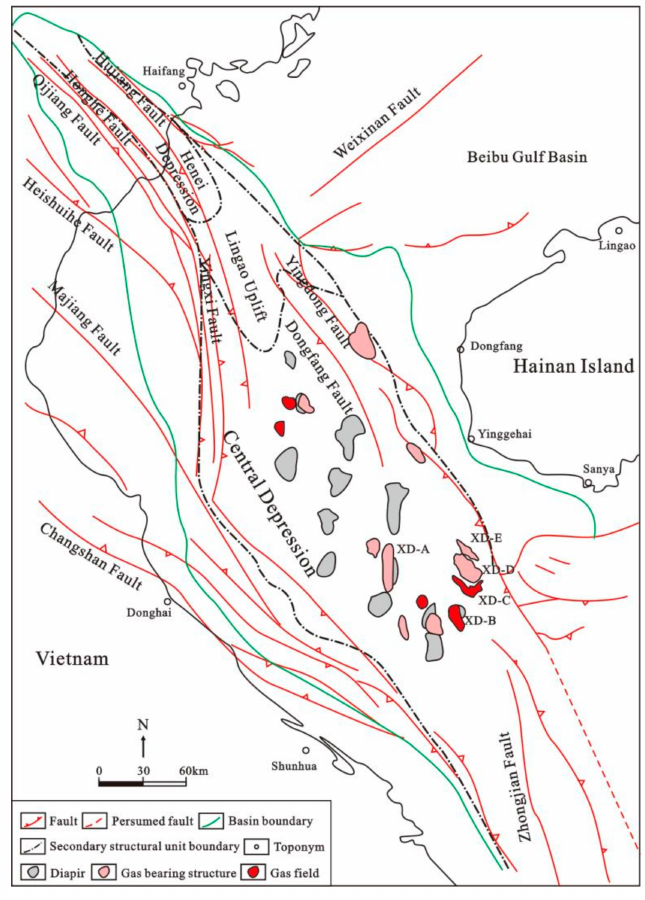
Figure 1. The structure outline map of Yinggehai